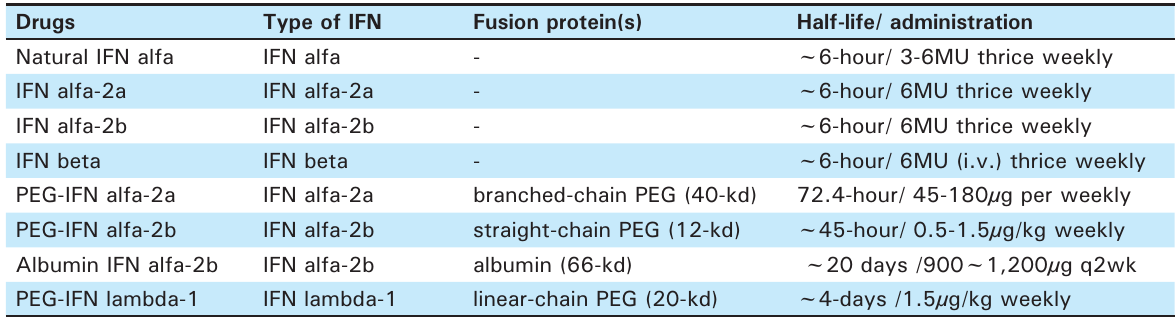
Table 1 Comparison of pegylated-interferon (PEG-IFN), standard interferon and so on. Drugs